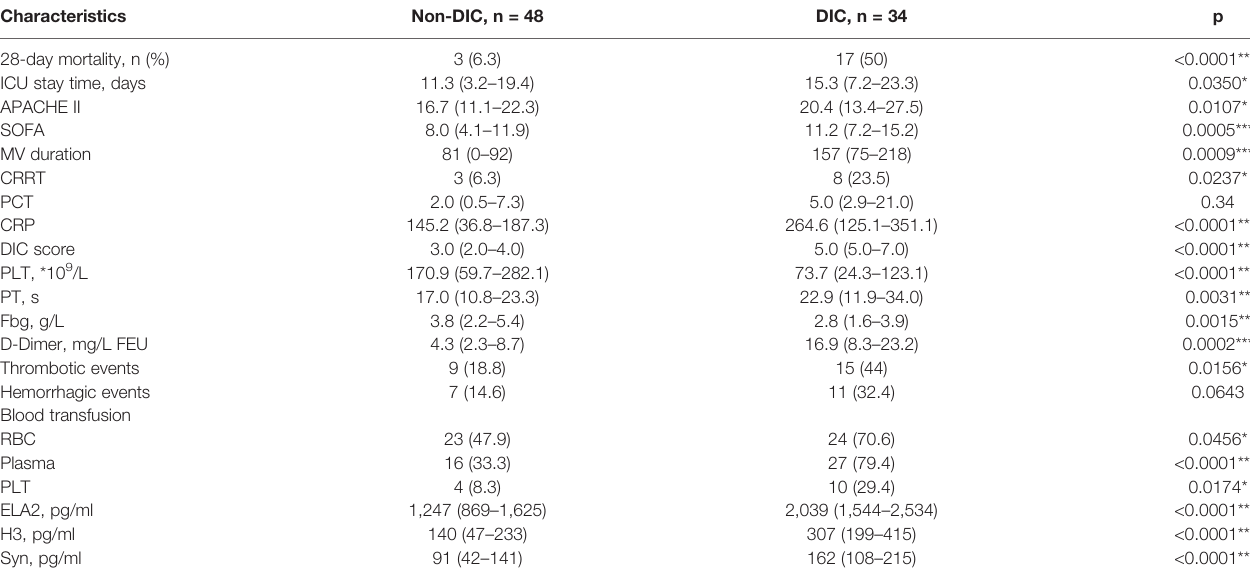
TABLE 2 | Laboratory parameters in different